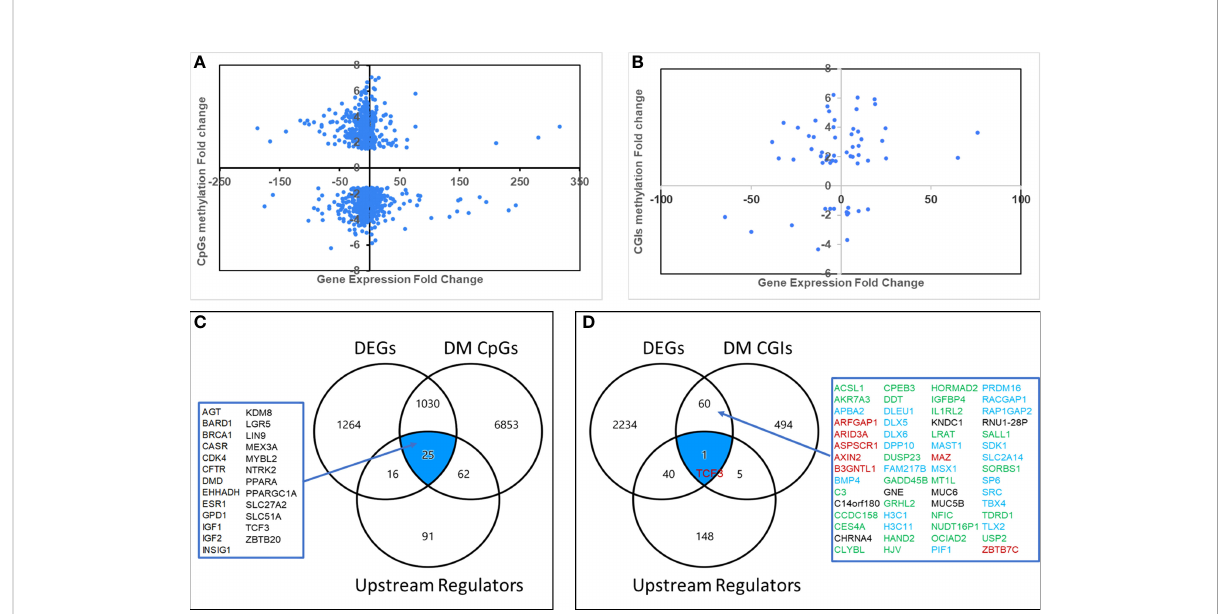
FIGURE 4 Aberrantly methylated-differentially expressed genes. Quadrant scattered plots showed differentially expressed genes (DEGs) with corresponding differentially methylated (DM) CpG sites (CpGs) (A) and DM CpG islands (CGIs) (B) . Venn diagrams showed 25 genes (C) identi fi ed by integrating DEGs, DM CpGs and Upstream Regulators, 61 genes (D) by overlapping DEGs and DM CpG islands, and one gene (TCF3) by overlapping DEGs, DM CpG islands and Upstream Regulators. Green: hypermethylated/downregulated genes, Blue: hypermethylated/upregulated genes, Red: hypomethylated/upregulated genes, Black: hypomethylated/downregulated